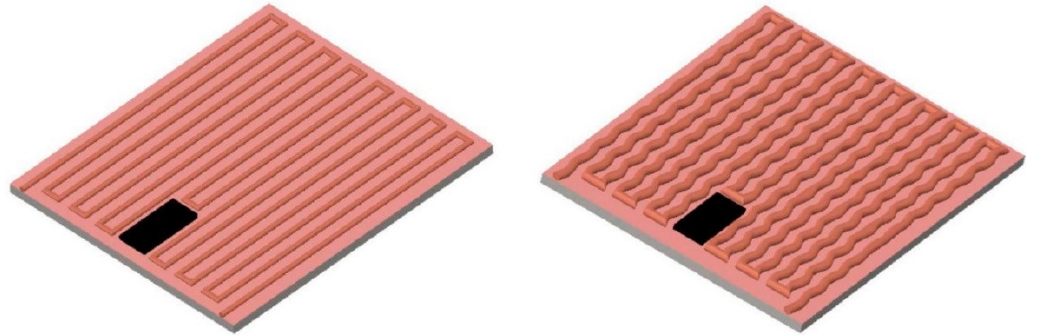
Figure 5. Model design of serpentine and sinusoidal serpentine configuration. Reprinted with permission from Ref. [101]. 2021. Shahsavar, A. permission from Ref. [101]. 2021. Shahsavar, A.